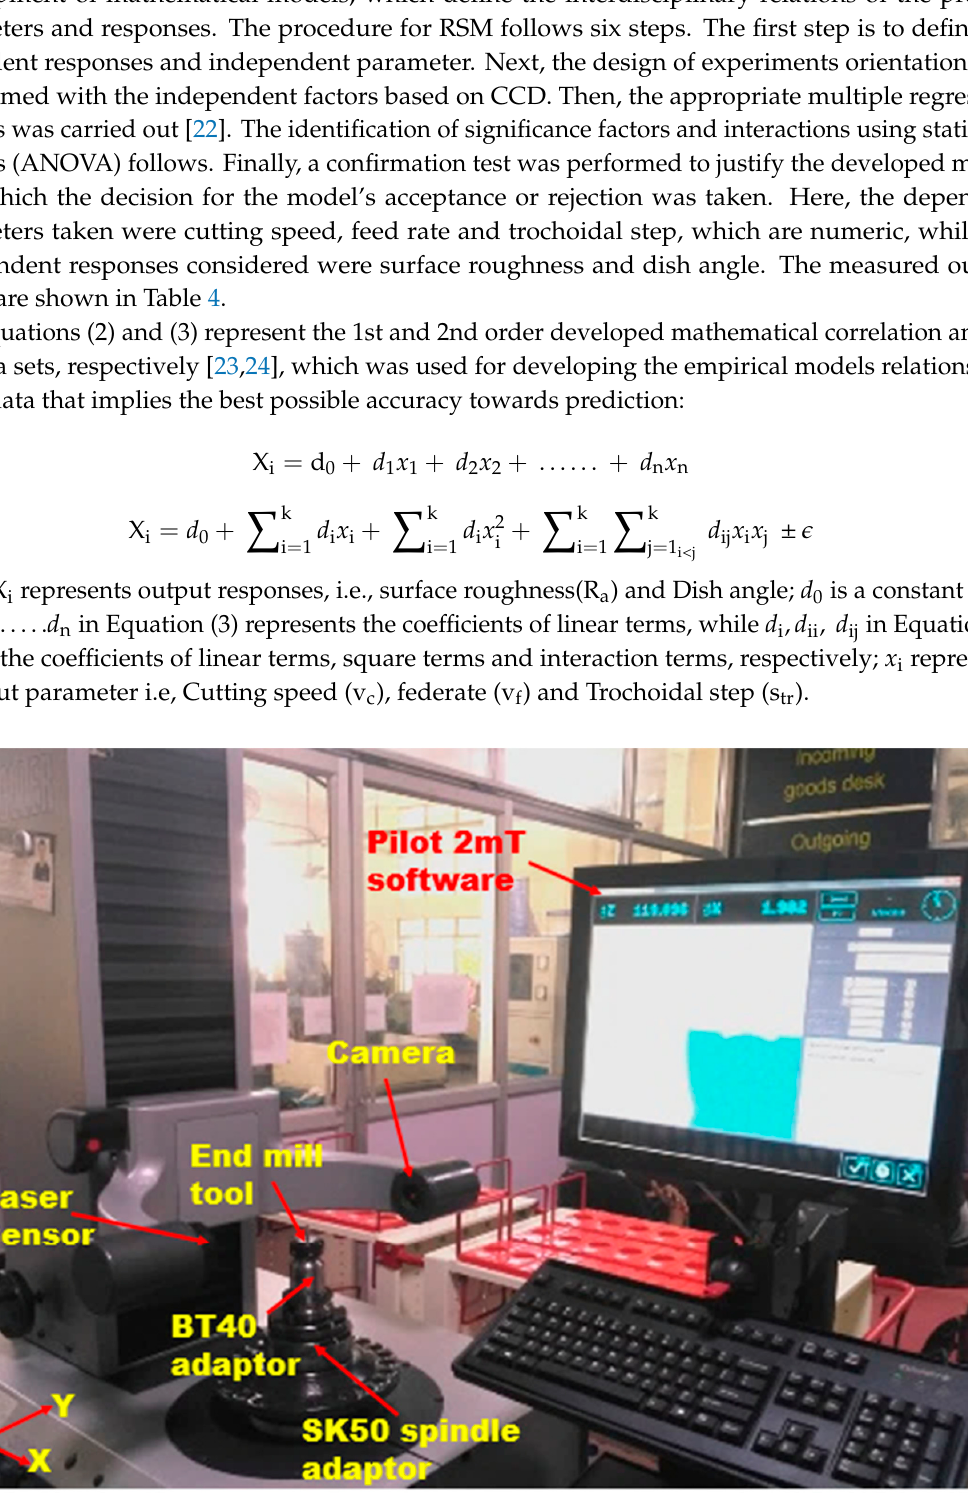
Figure 5. Zoller Junior Plus tool pre-setter used for dish angle measurement.